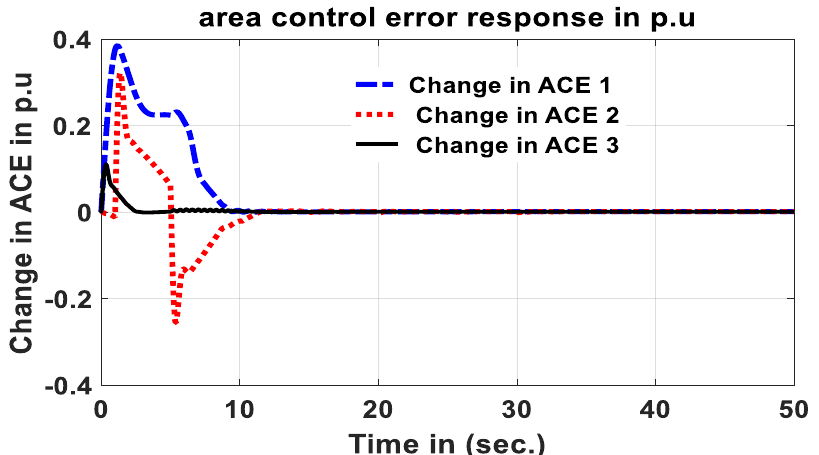
Figure 26. Change in area control error responses of area 1, area 2, and area 3 for random load change in area 2 only.